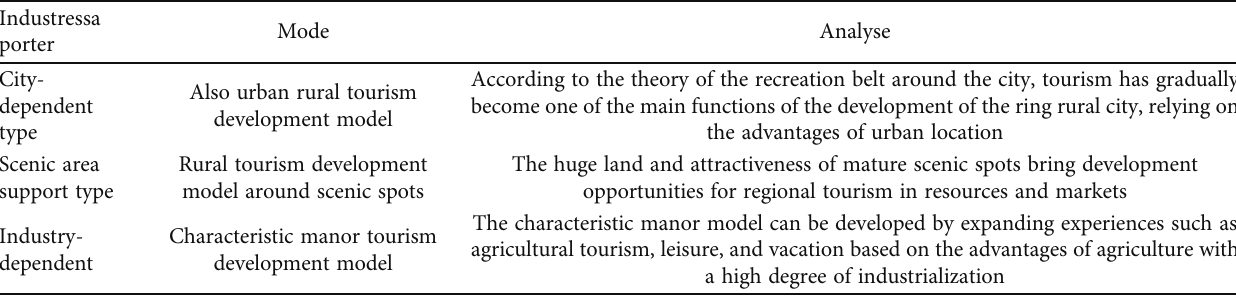
Table 3: The current model of rural development in